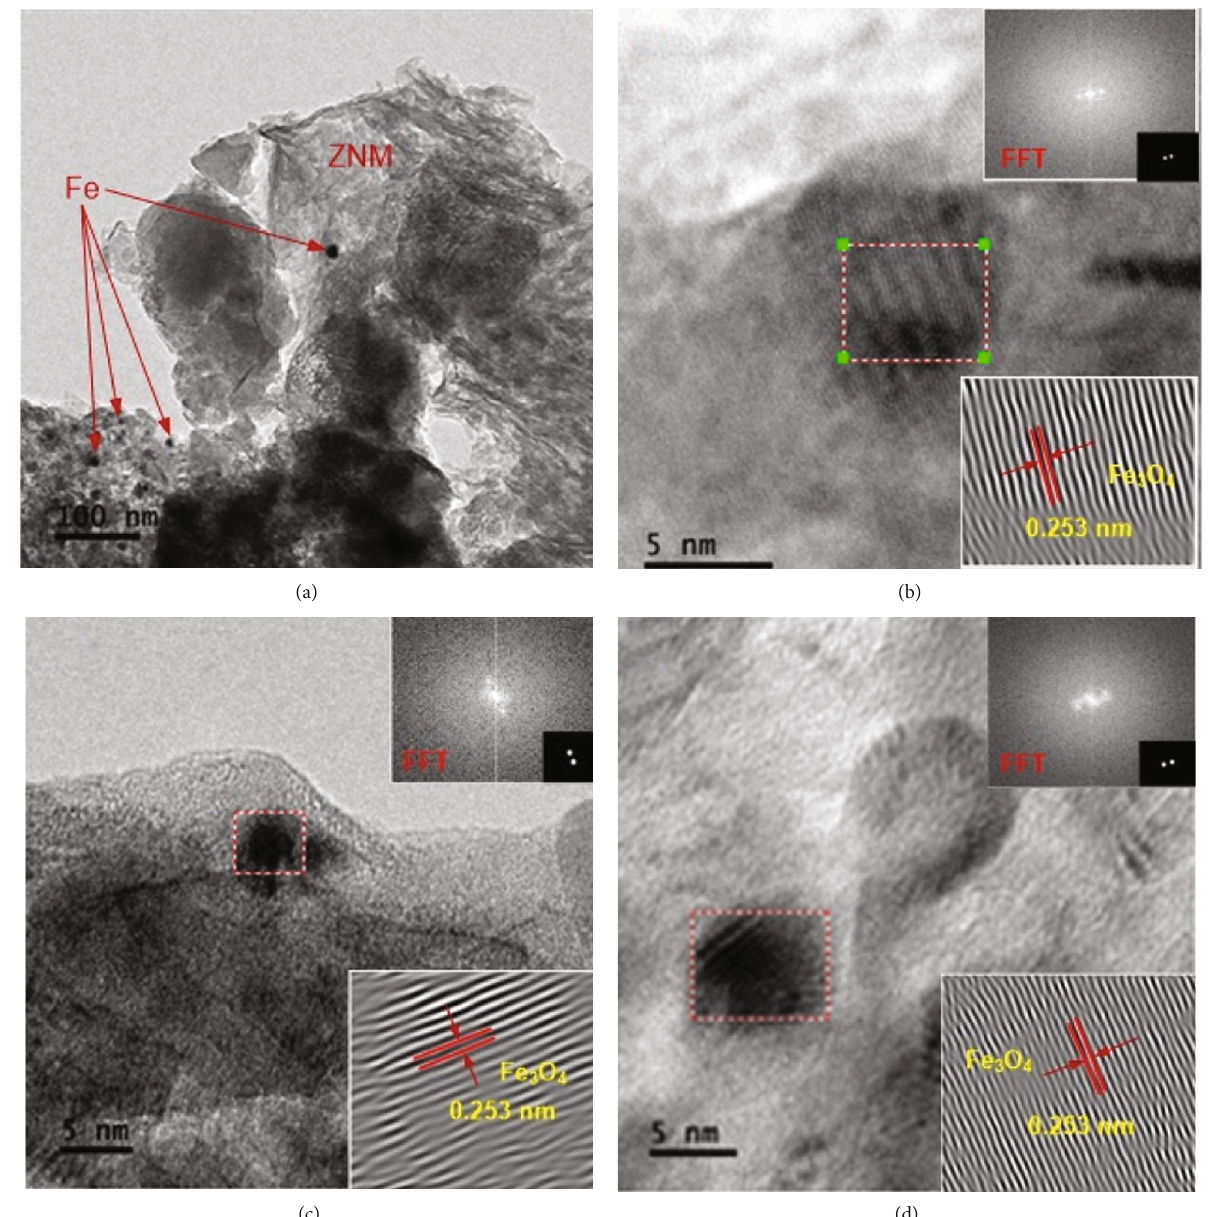
Figure 7: TEM images of uncalcined MNZ/Fe: (a) scale of 100 nm, (b-d) scale of 5